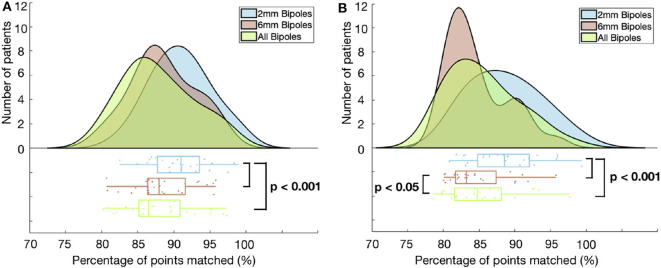
Histogram and corresponding boxplot showing the percentage of points matched in SR (A) and AF (B) for each of the three electrode distance categories. Each category is shown in a different color: 2 mm (blue), 6 mm (red), all (green). p-value calculated with paired-sample t-test.